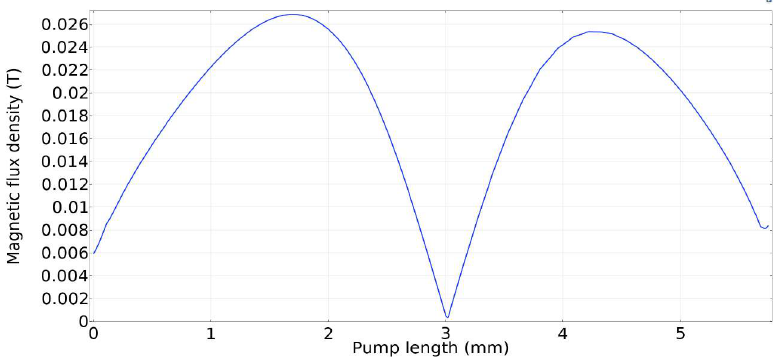
Figure 9. Magnetic flux density on the upper MRE wall and across the pump length .